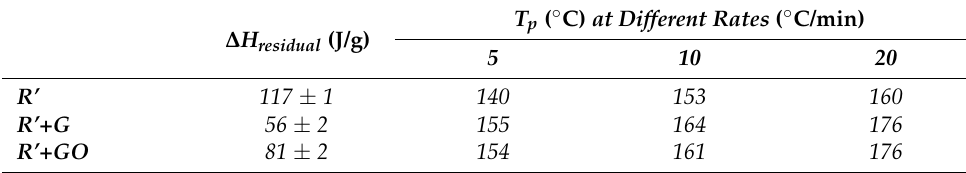
Table 10. Residual enthalpy and curing peak of R’ and R’+GBN after UV exposure.